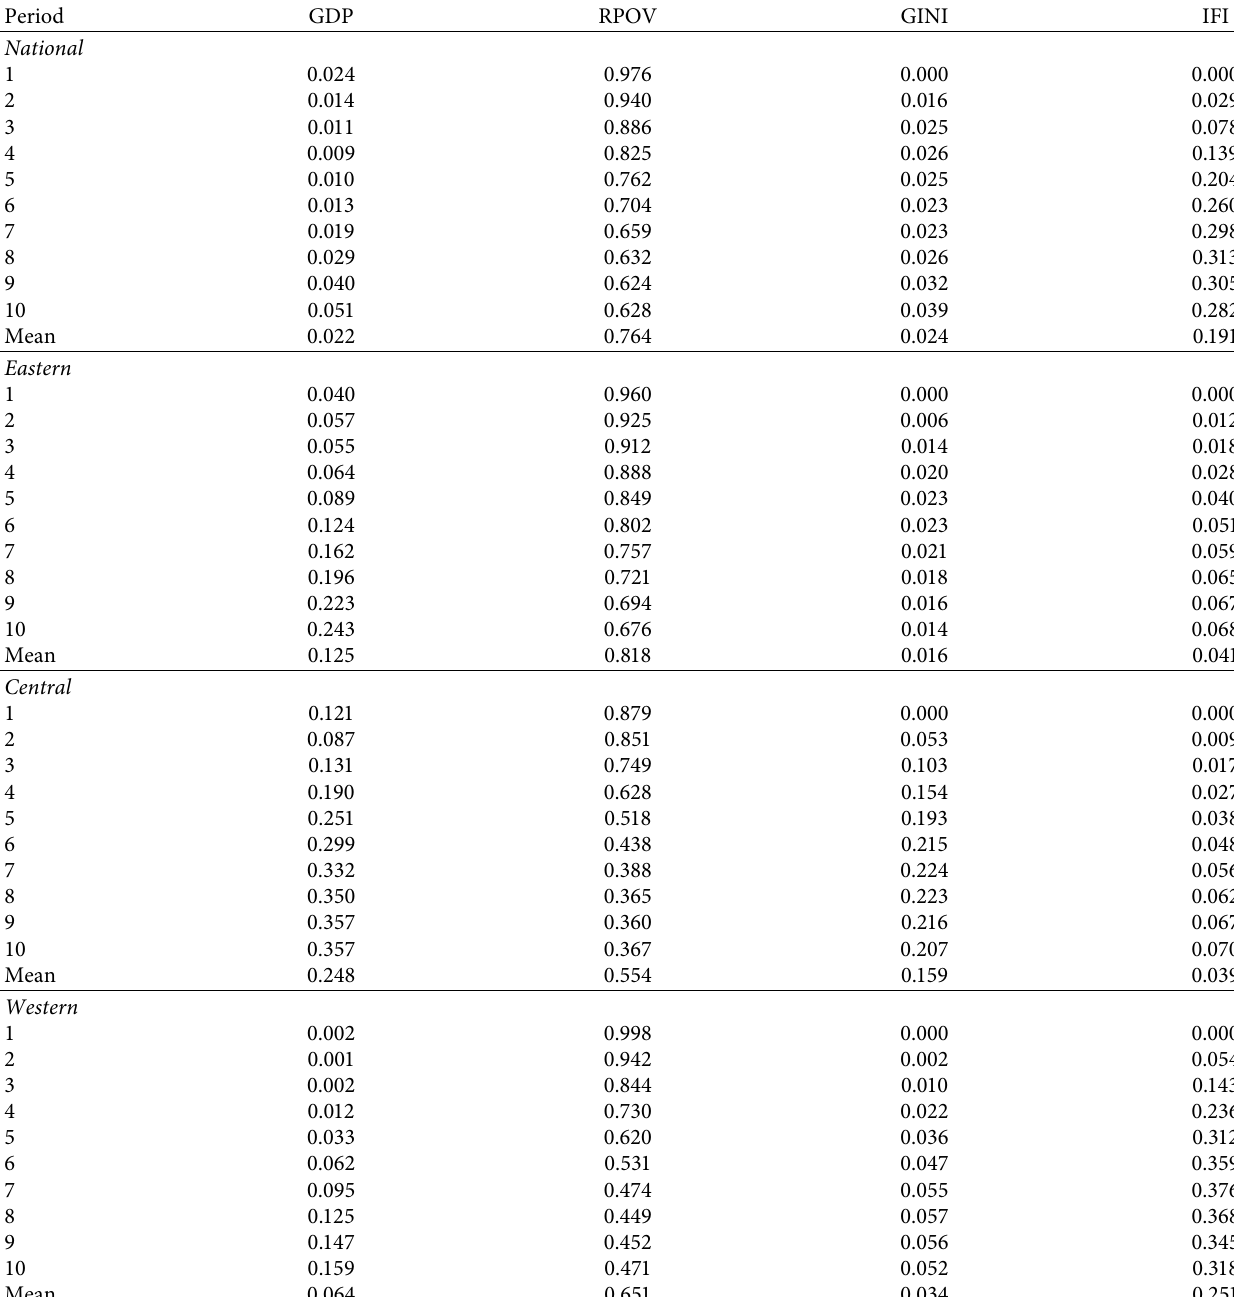
Table 5: Variance decomposition results of